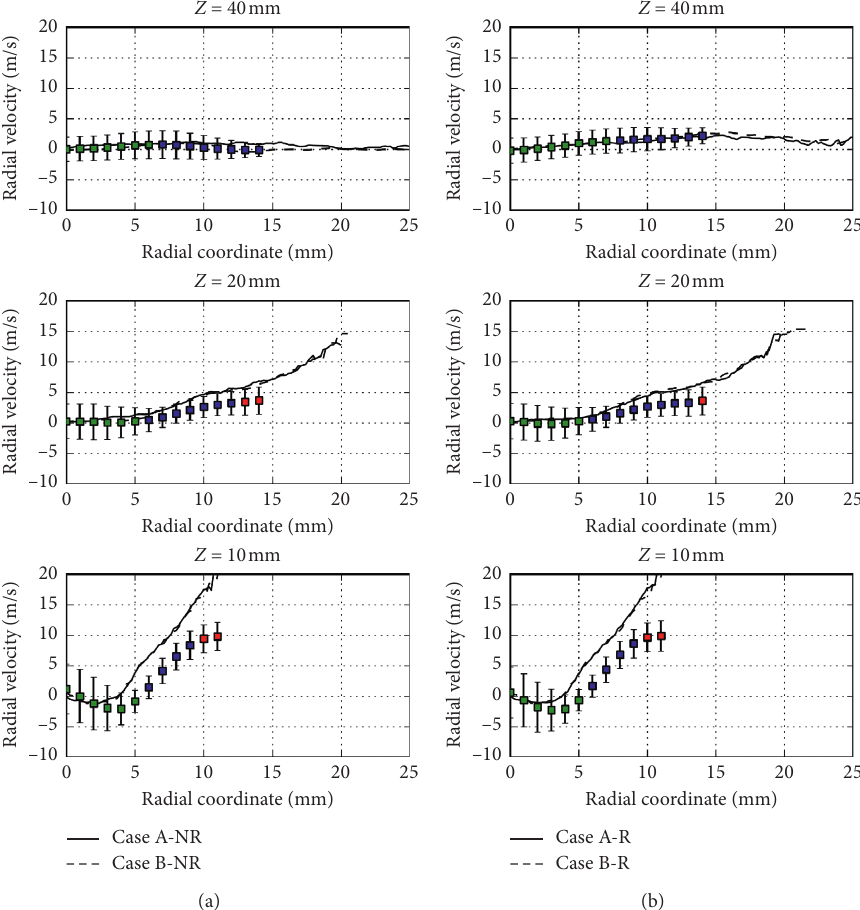
Figure 25: Radial profiles of droplet radial velocity for nonreacting (a) and reacting case (b). Symbols: experiments, solid line: case A dashed line: case B.